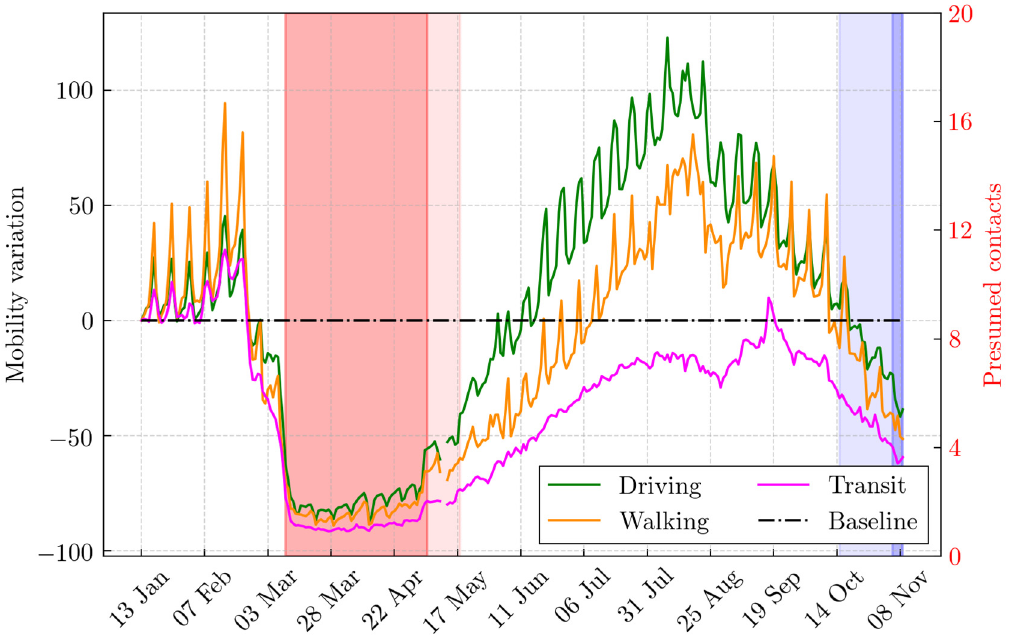
Figure A1. Apple mobility trends and the corresponding presumed contacts. Mobility trends provided by Apple, expressed as percentage variation with respect to the baseline in Italy between 13 January and 9 November 2020, are reported by straight lines with values on the y-axis, left side. On the y-axis, right side, the presumed contacts have been reported according to the mobility trend.